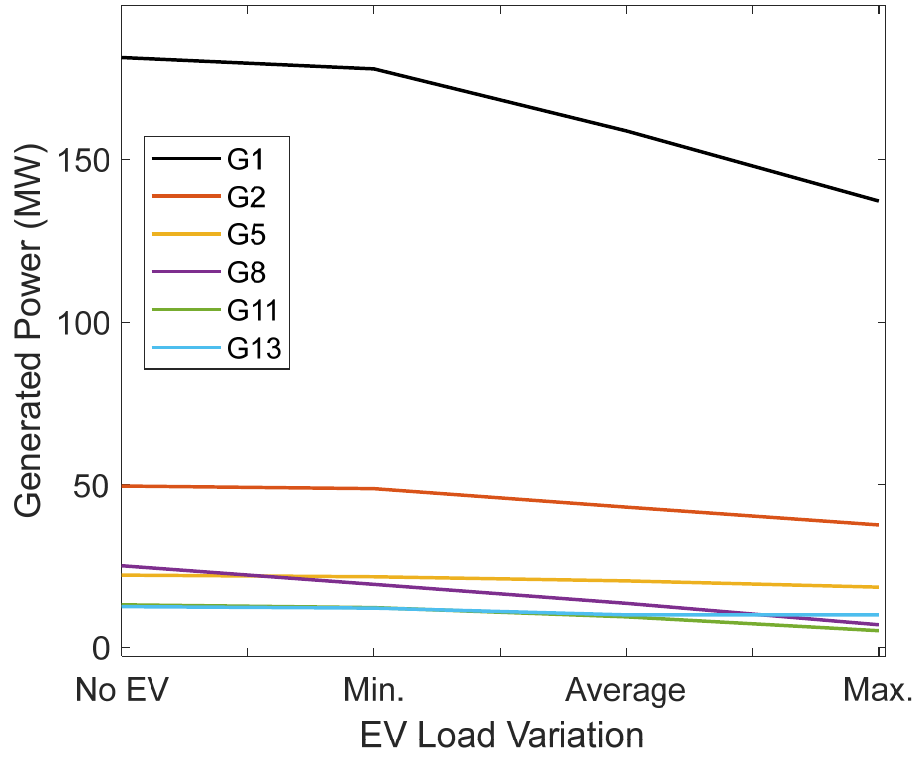
Figure 16. The variation of the generated power from the conventional generators connected to the IEEE 30 bus systems with the use of DR and V2G.